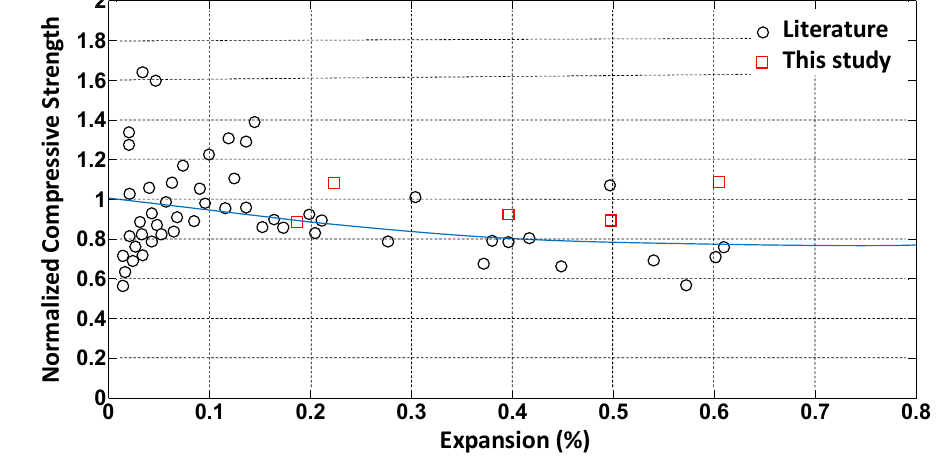
Figure 1. Normalized compressive strength versus ASR expansion.